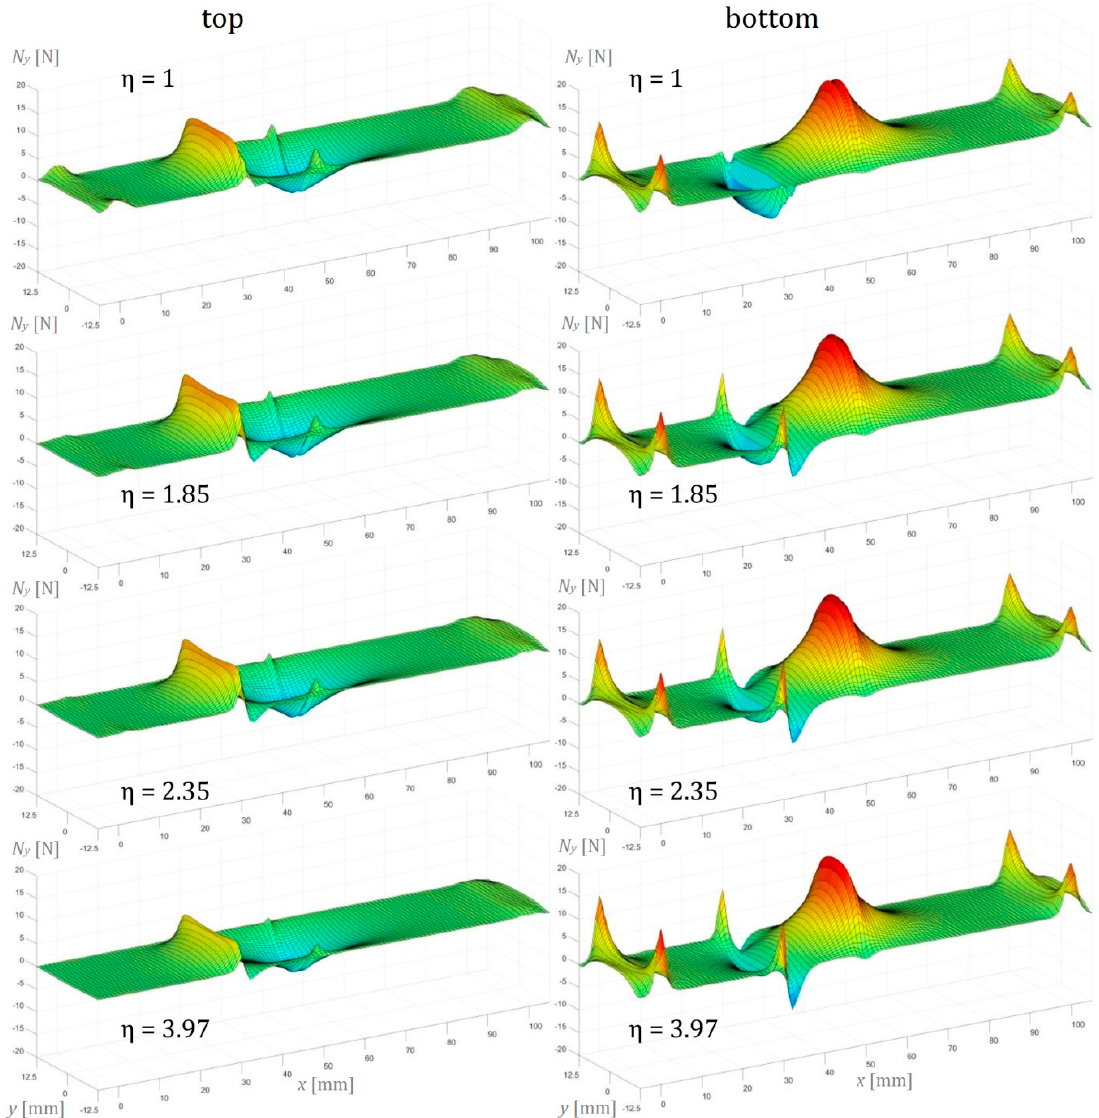
Figure 14. Normal forces per unit width in the transversal direction N y of the AENF.